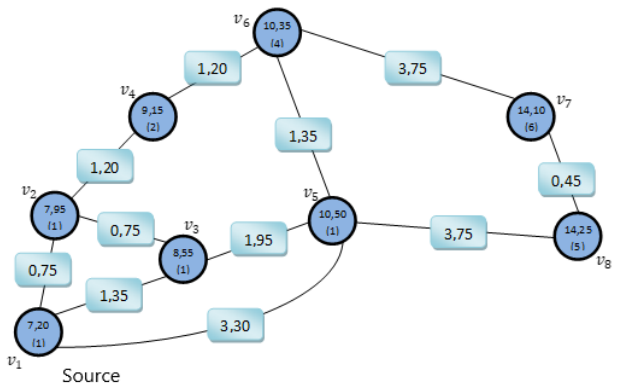
Figure 12. Finding the optimal path from peak 1—finalization.